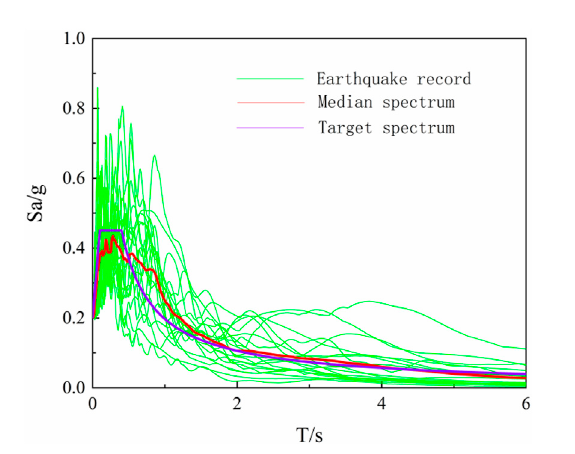
Acceleration response spectrum of main-aftershock